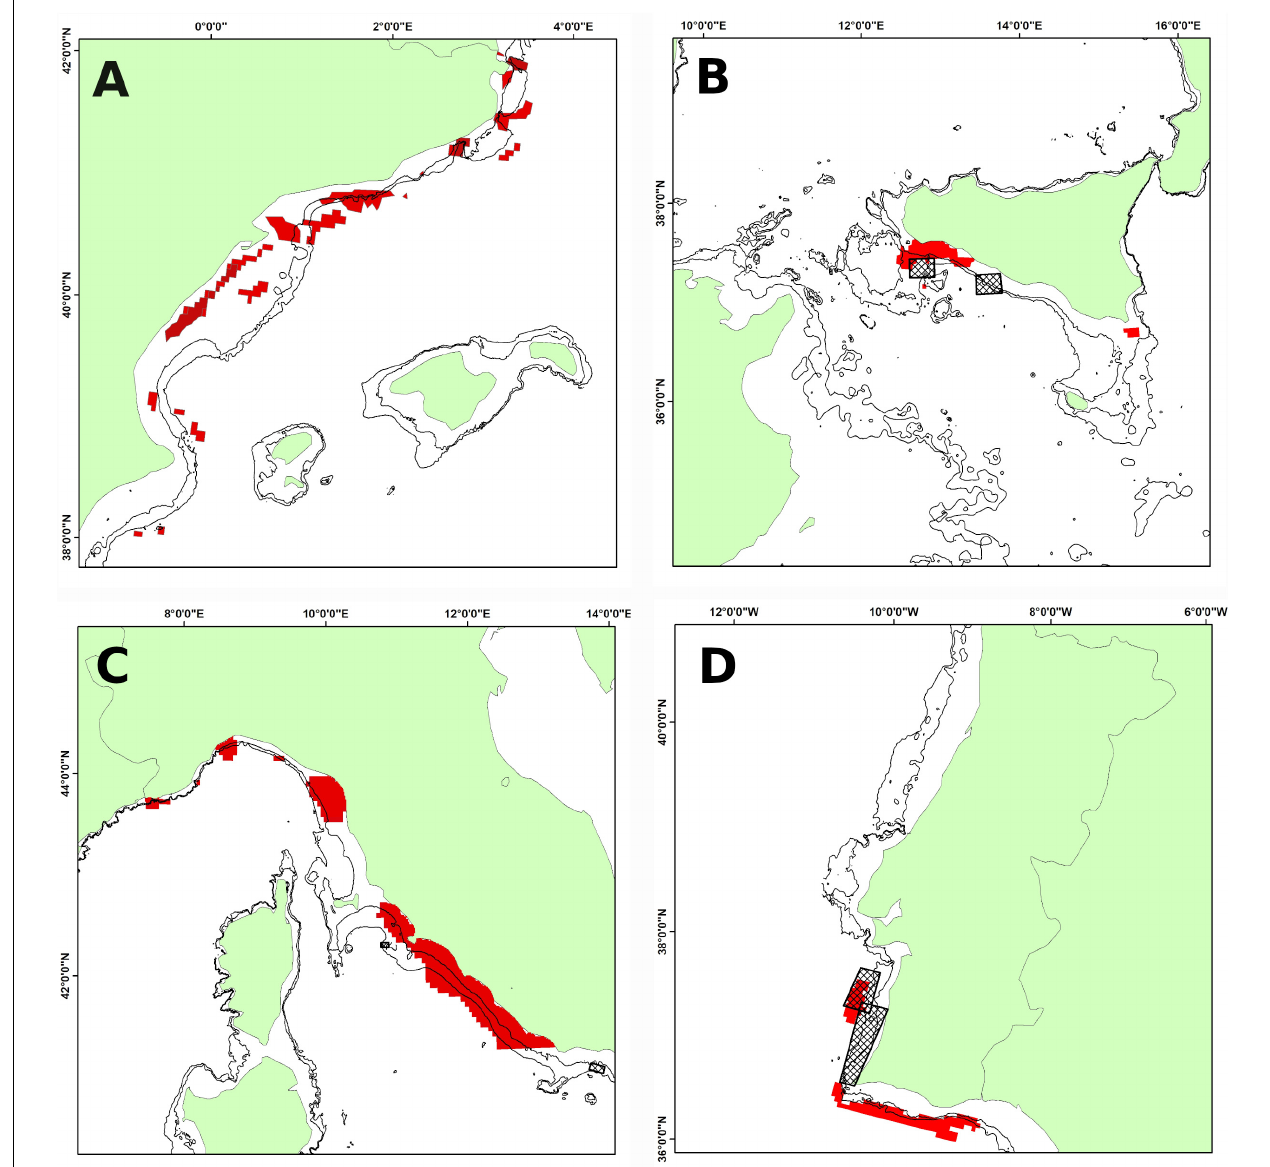
FIGURE 7 | Zones with high persistence of fishing effort (EPI ≥ 0.8). Depth contours shown are 100 and 200 m. (A) Area 1; (B) Area 2; (C) Area 3; (D) Area 4. The square boxes indicate the fishing restricted